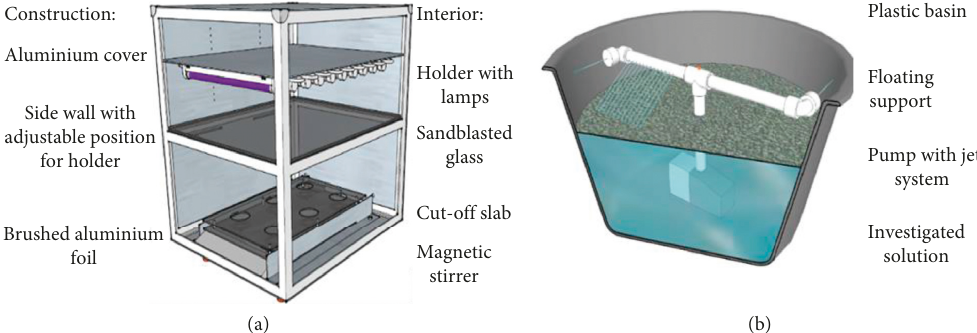
Figure 2: Photoreactors of our own design and construction. (a) Laboratory photoreactor. (b) Outdoor photoreactor.